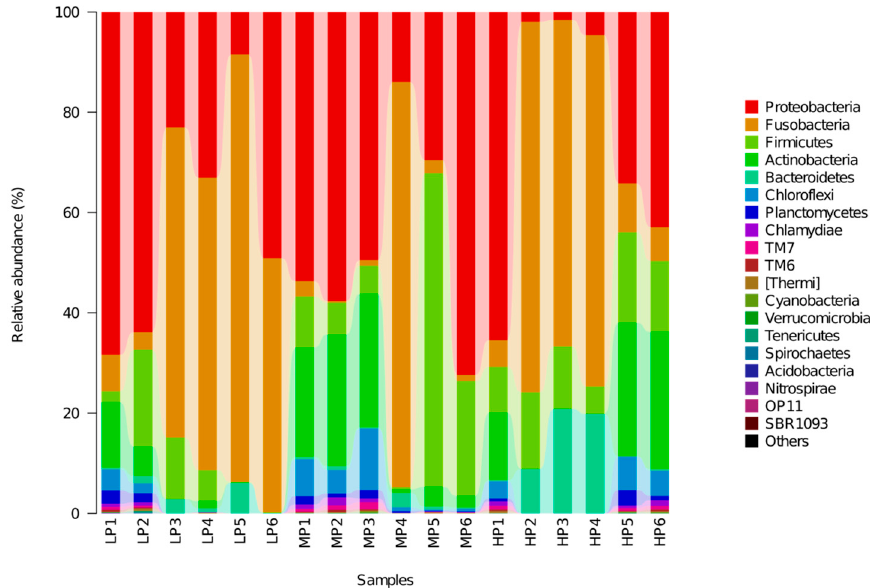
Figure 2. Relative abundance of intestinal bacterial communities at the phylum level.